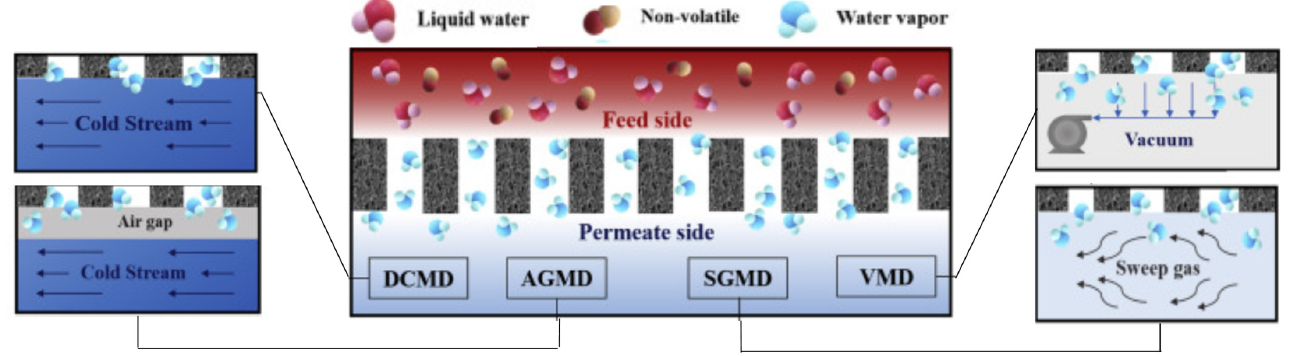
Figure 8. Schematic illustration of different approaches for the conventional MD process: direct contact membrane distillation (DCMD), air-gap membrane distillation (AGMD), sweep gas membrane distillation (SGMD), and vacuum membrane distillation (VMD). Based on Anvari et al. [87].